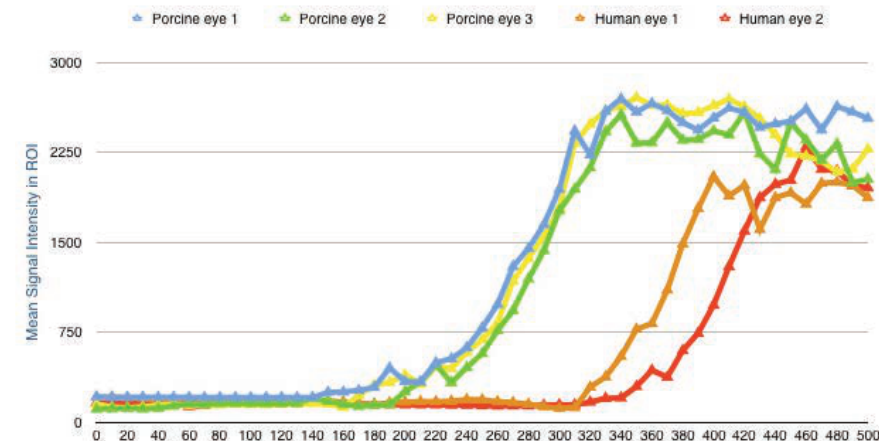
Figure 3. Rise in fluorescence after fluorescein injection into the anterior chamber in porcine and human eyes. The units are fluorescent arbitrary units (au). The plot shows that the optimal time to capture image is five minutes after injection in porcine eyes and seven minutes after injection in human eyes. ROI, region of interest